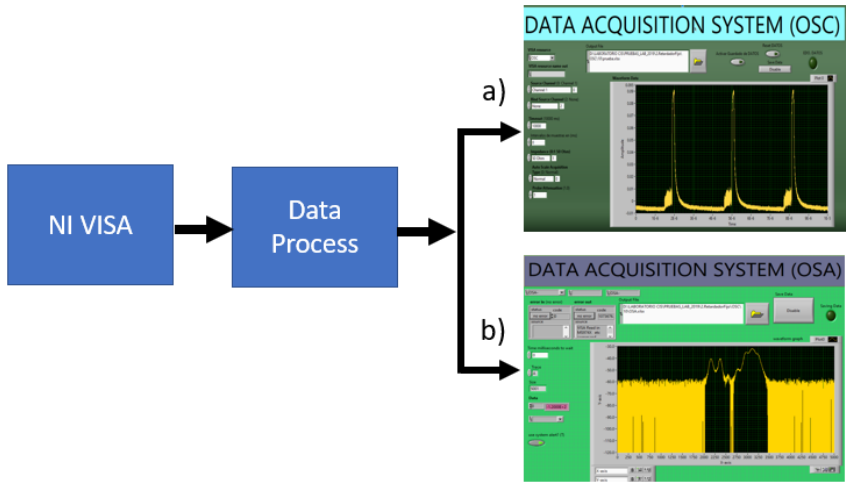
Figure 4. Graphical interface data environment remotely system: temporal ( a ) OSC and spectral ( b ) OSA.